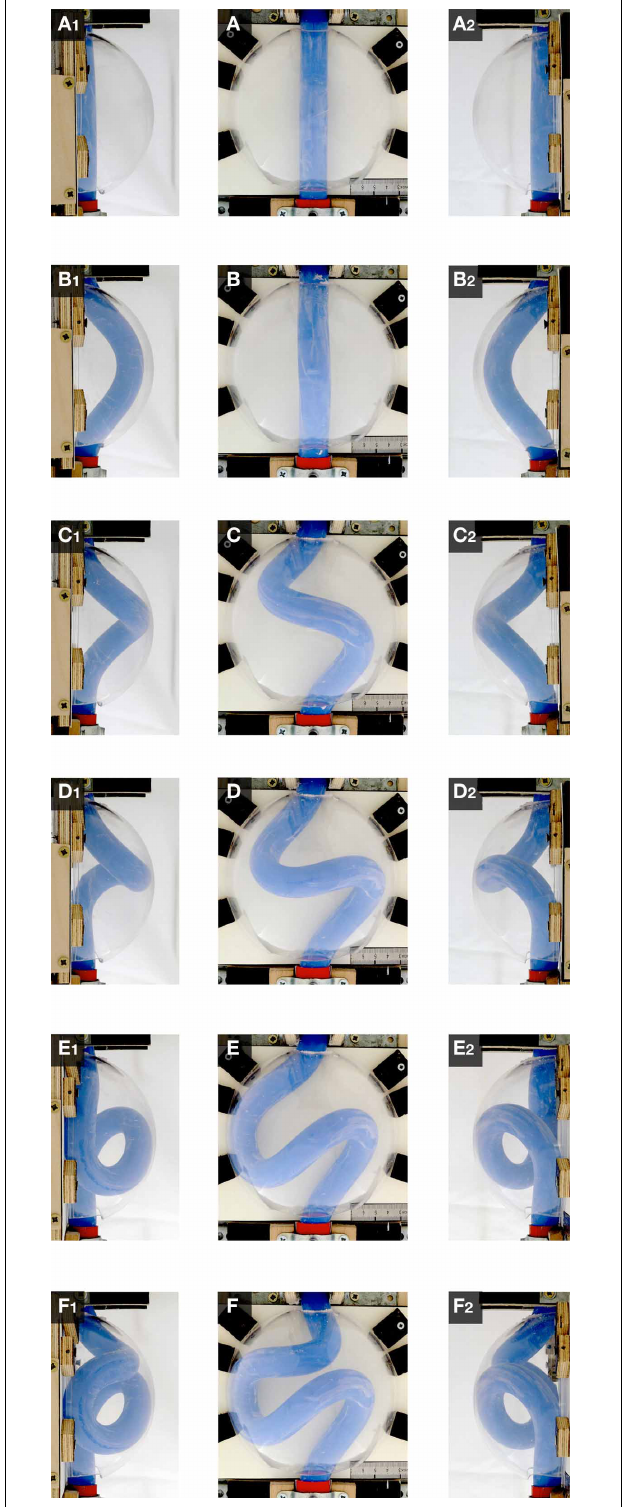
FIGURE 5 | These photographs taken at frontal (A–F), right-lateral (A1–F1), and left-lateral views (A2–F2), document the shape changes of